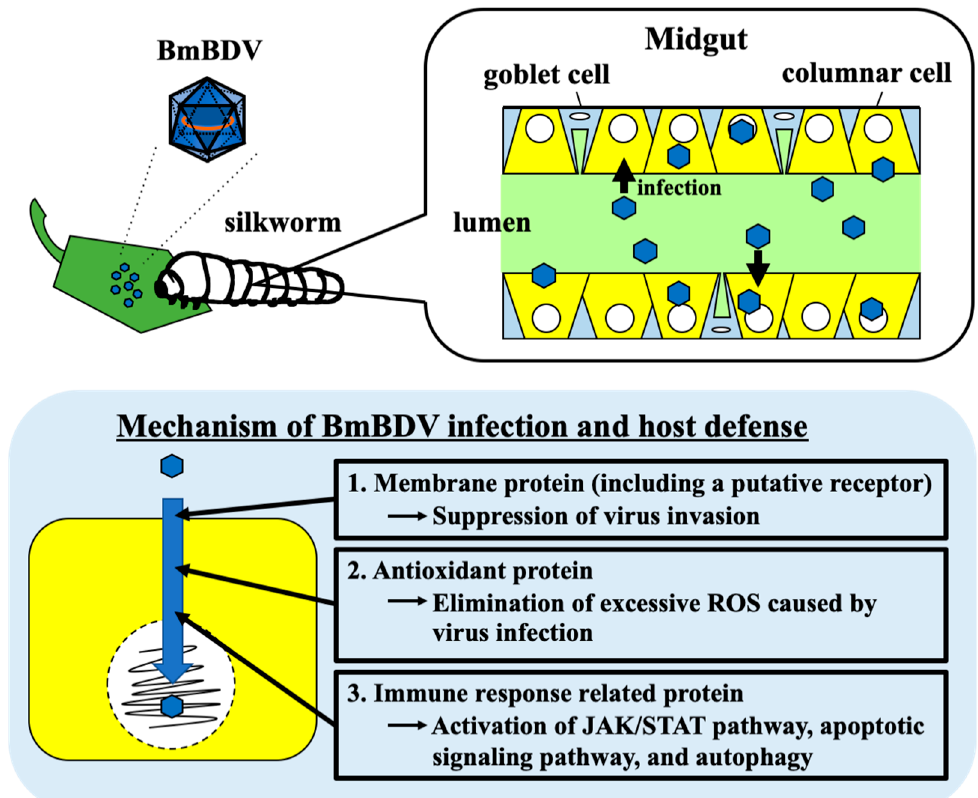
Figure 6. The BmBDV infection mechanism and host defense.